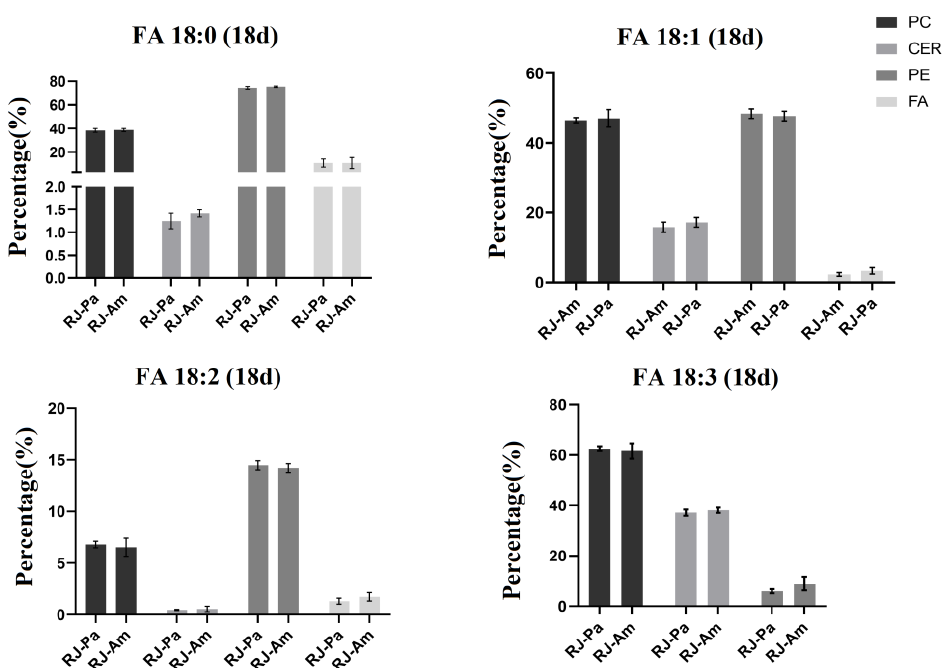
Figure 4. The ratio of free and bound 18-carbon saturated and unsaturated fatty acids in royal jelly secreted by honeybees fed single bee pollen derived from Acer mono Maxim. (BP-Am) or Phellodendron amurense Rupr. (BP-Pa). RJ-Am, royal jelly secreted by honeybees fed BP-Am; RJ-Pa, royal jelly secreted by honeybees fed BP-Pa.